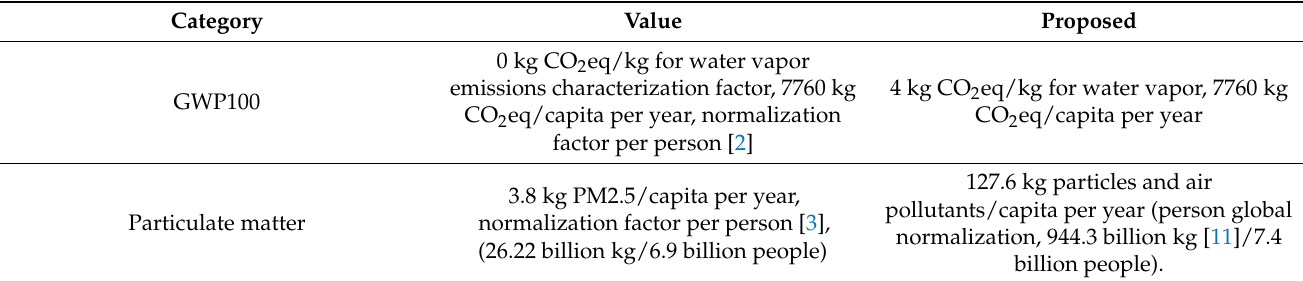
Table 2. Characterization factors for water vapor and normalization factors particulate matter. Category